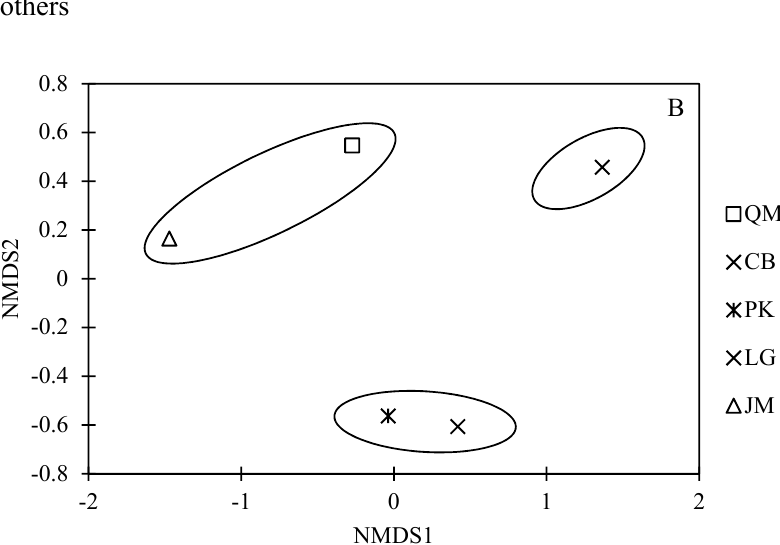
Figure 5. Comparison of microbial communities in soils under five different revegetation types. The relative abundance of the dominant bacterial phyla ( A ). A two-dimensional sample sequencing diagram of nonmetric multidimensional scaling (NMDS) based on the analysis of Bray-Curtis distance ( B ). LG: Larix gmelinii ; PK: Pinus koraiensis ; CB: Conifer-broadleaf forest; JM: Juglans mandshurica ; QM: Quercus mongolica